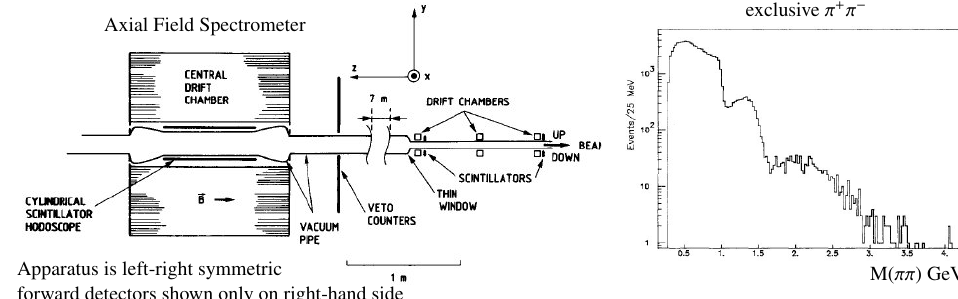
Figure 2. The Axial Field Spectrometer at the ISR (taken from Ref.